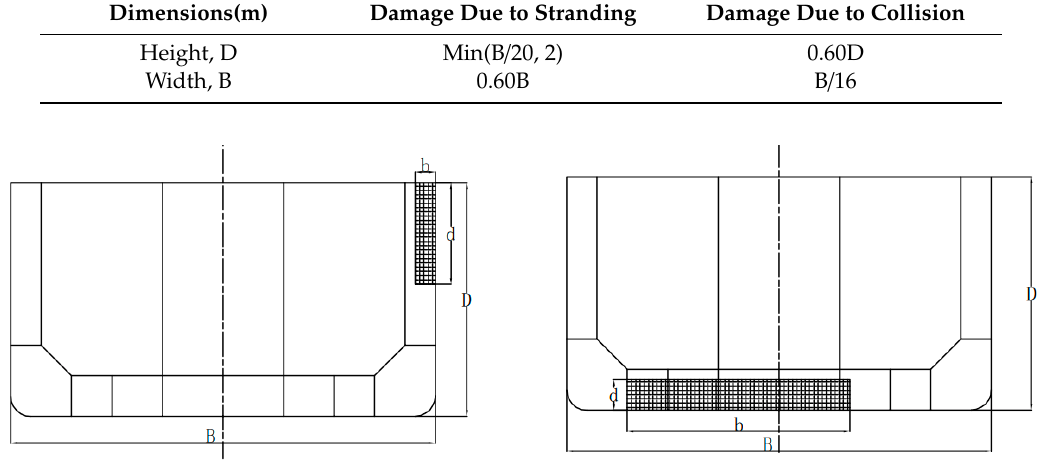
Table 4. Cases for validating the PSO-based Smith Method.